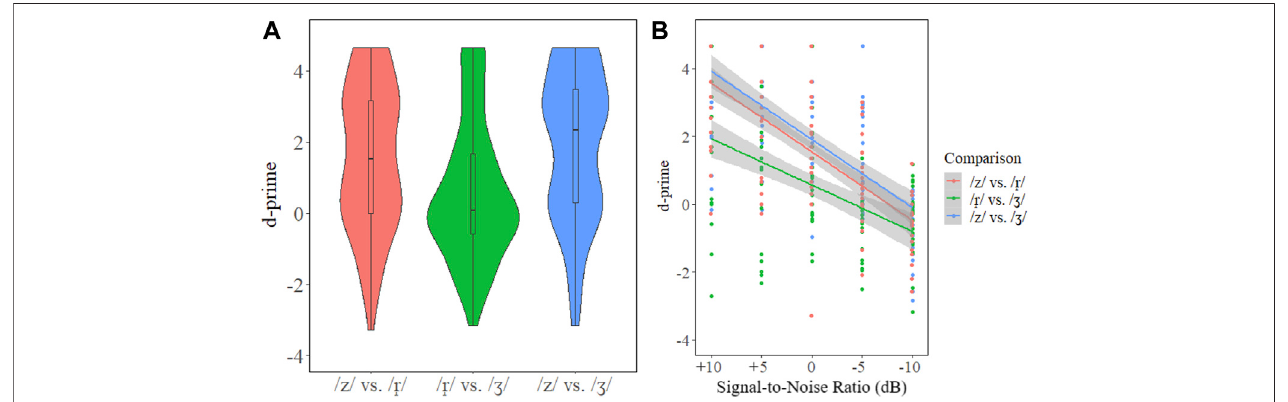
FIGURE 2 | Violin plot for the Czech d-prime results (A) . Scatterplot of the d-prime results with regression lines for the factor Signal-to-Noise Ratio (B) .